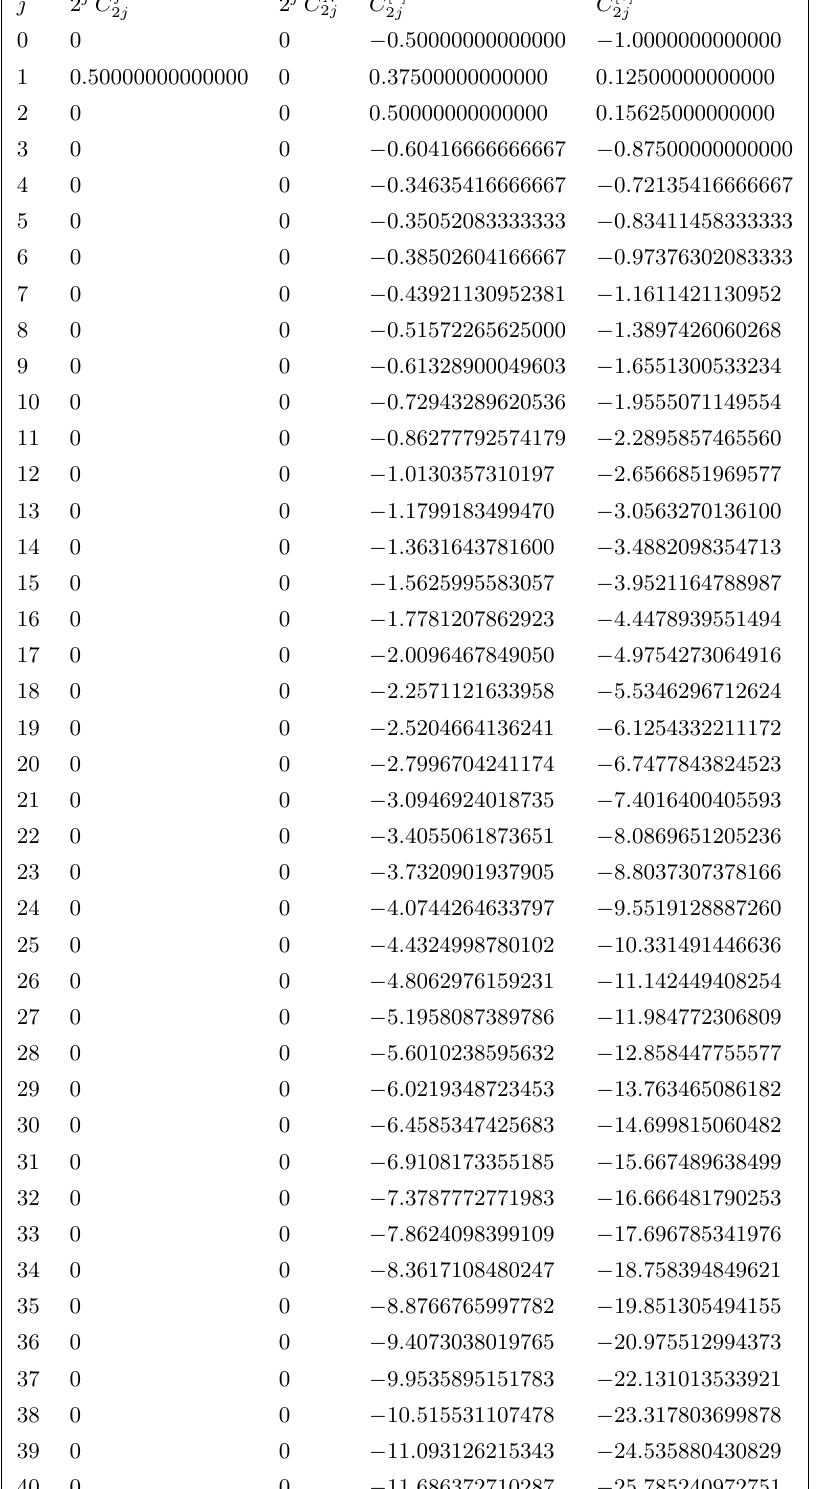
Table 8 . Coe(cid:14)cients of the term including ln 2 (1 (cid:0) z ) in the asymptotic expansion at z =